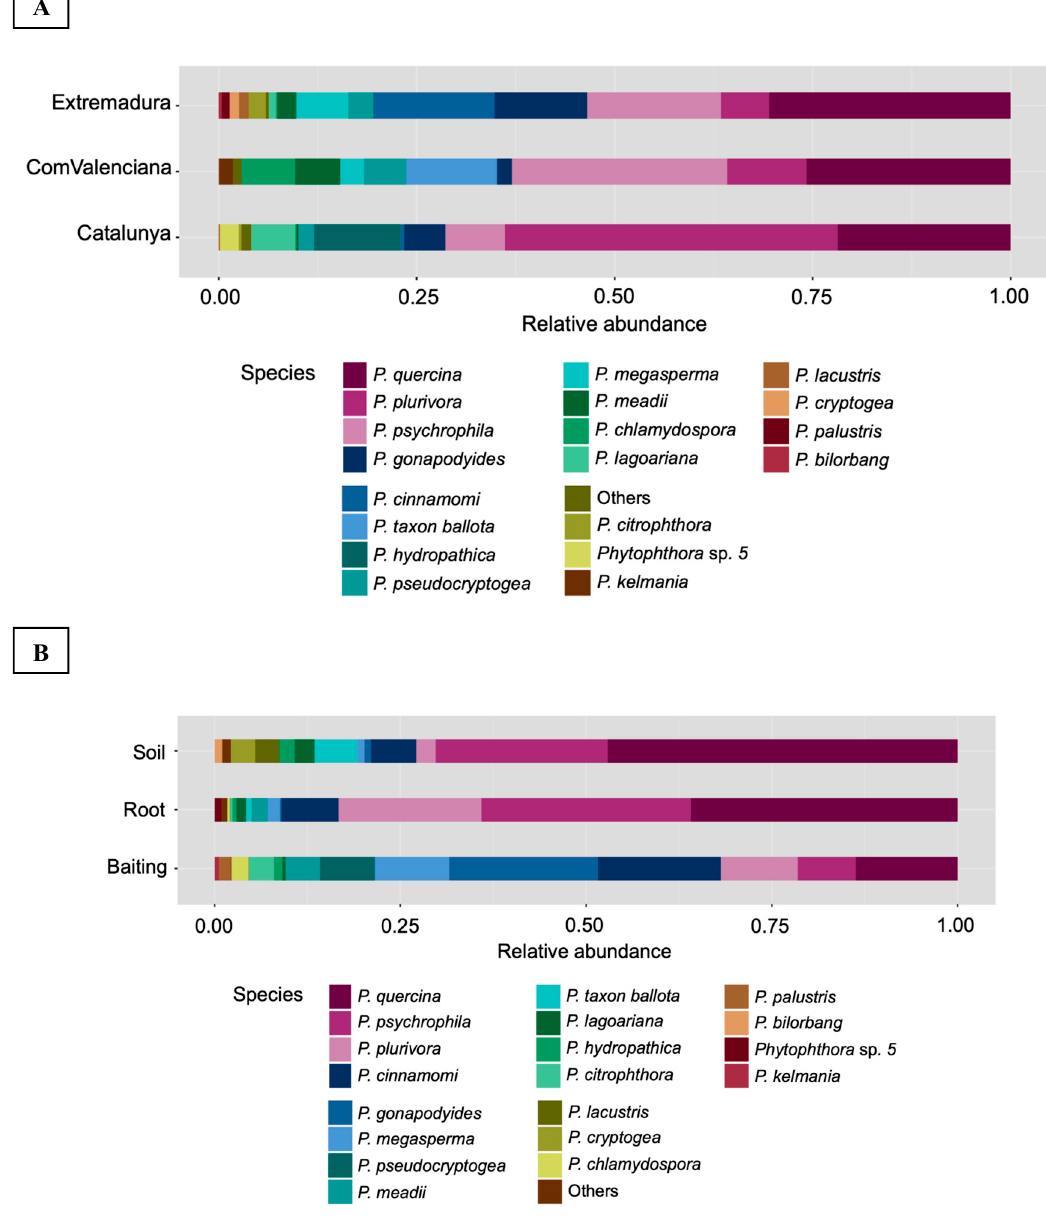
Figure 1. Relative abundance of Phytophthora species detected in the three studied regions from 2013 to 2015 showing more than 1% relative abundance of all reads. Species representing less than 1% of the total reads are grouped in “others”. ( A ): According to the factor region; Extremadura, Comunidad Valenciana (ComValenciana) and Cataluña (Catalunya). ( B ): According to the factor type of material; soils, roots and baitings. Results of the survey performed in Extremadura in 2012 are excluded in this analysis, since only soil samples were included.